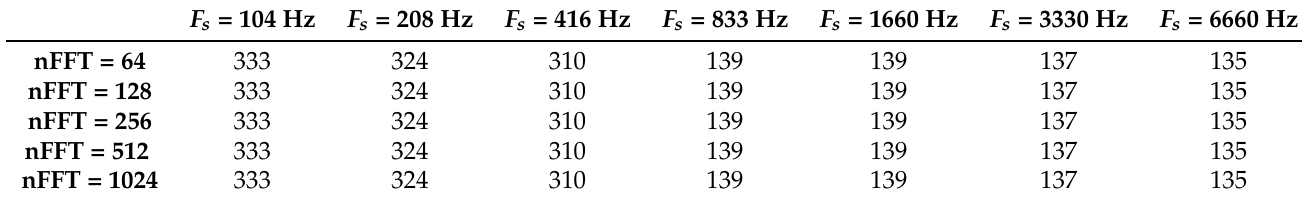
Table 7. Battery duration in hours for RT controller and operating mode T OFF = 0.